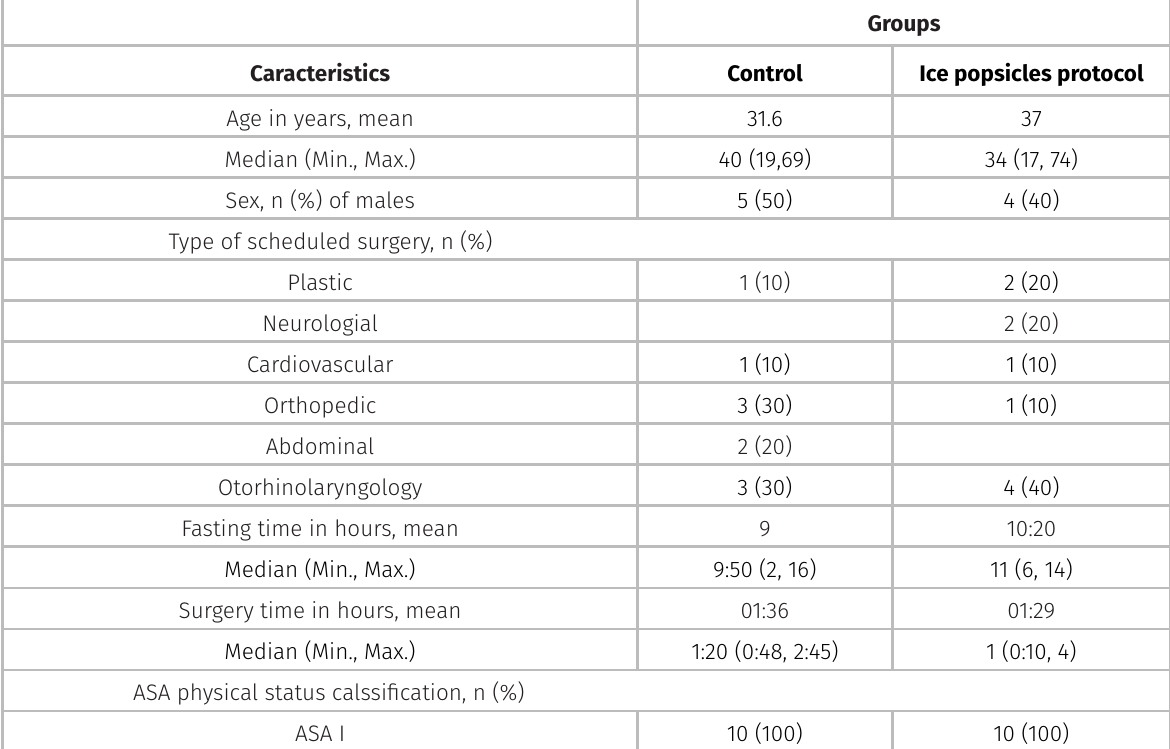
Abbreviation: ASA, American Society of